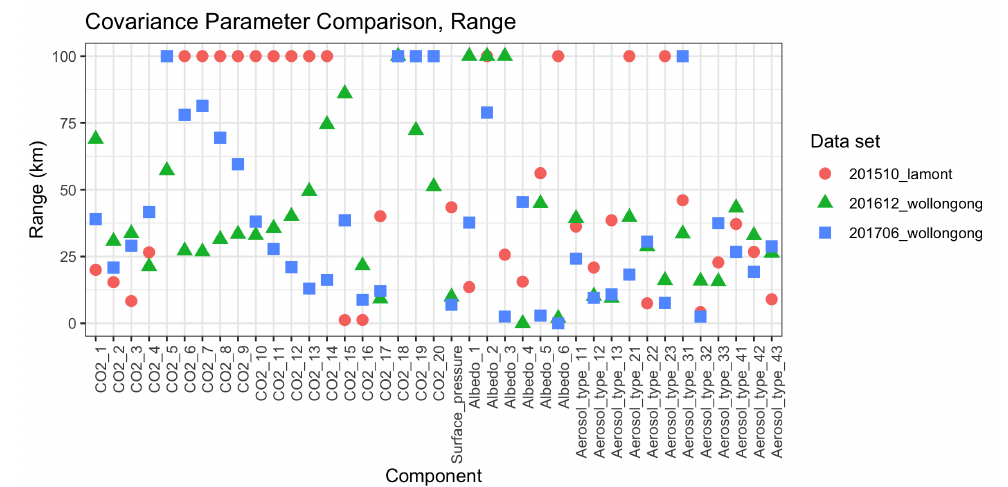
Figure 2. Estimated Matérn spatial correlation range parameters in kilometers for all state vector elements in three Total Carbon Column Observing Network (TCCON) templates. Estimates have been truncated above at 100